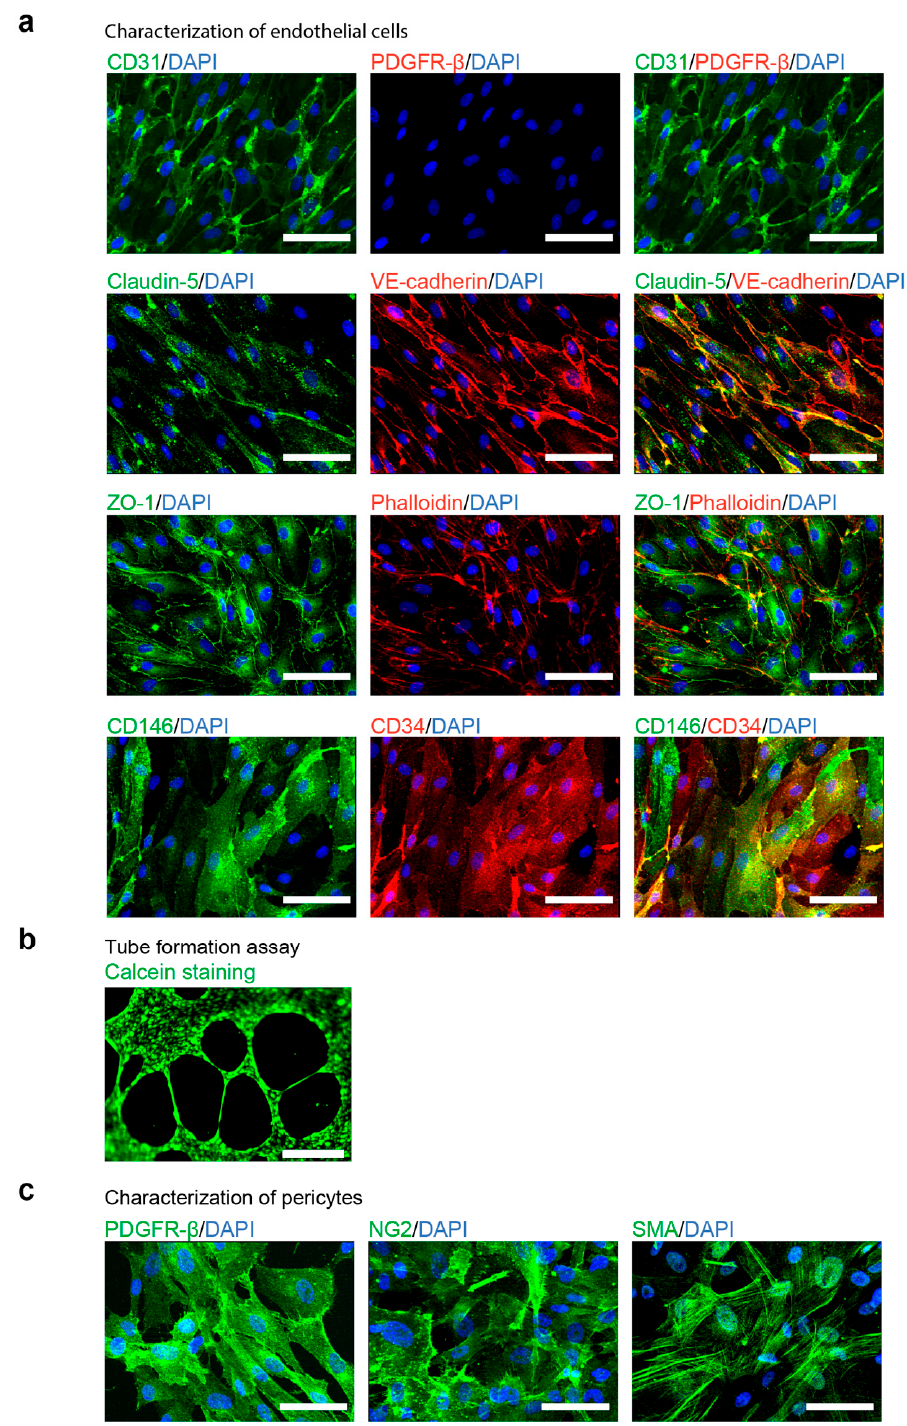
Figure 2. Characterization of differentiated endothelial cells (ECs) and pericytes. ( a ). Fluorescent imaging analysis of ECs positively sorted by CD31 expression with MACS system. ECs express endothelial markers CD31, vascular endothelial cadherin (VE-cadherin), CD34 and CD31 as well as components of tight junctions (zonula occludens 1 (ZO-1) and Claudin-5) but not the pericyte marker Platelet Derived Growth Factor Receptor β (PDGFR- β ); scale bars: 50 µ m. ( b ). In-vitro tube formation assay of ECs plated on Matrigel for 16 h; Calcein live-cell staining; scale bar, 500 µ m. ( c ). Fluorescent imaging analysis of pericytes, expressing Platelet Derived Growth Factor Receptor β (PDGFR- β ), Neural/glial antigen 2 (NG2) and smooth muscle actin a (SMA); scale bars: 50 µ